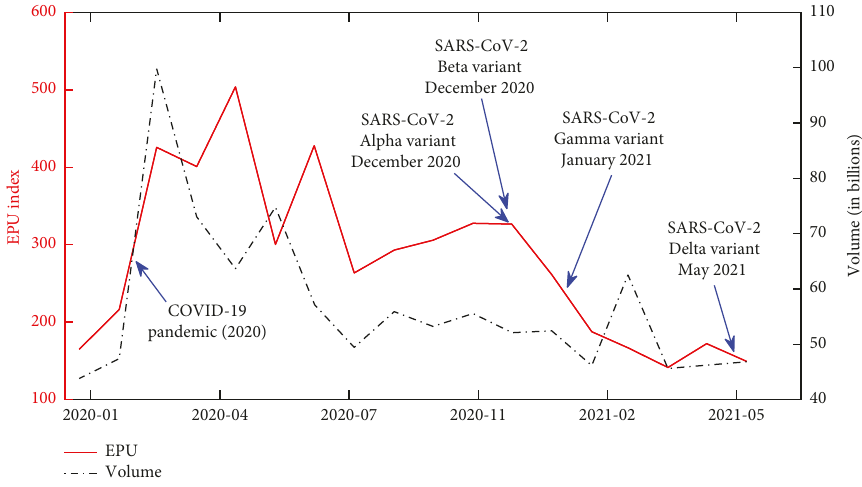
Figure 3: The monthly EPU index and total volume from January 2020 to July 2021.